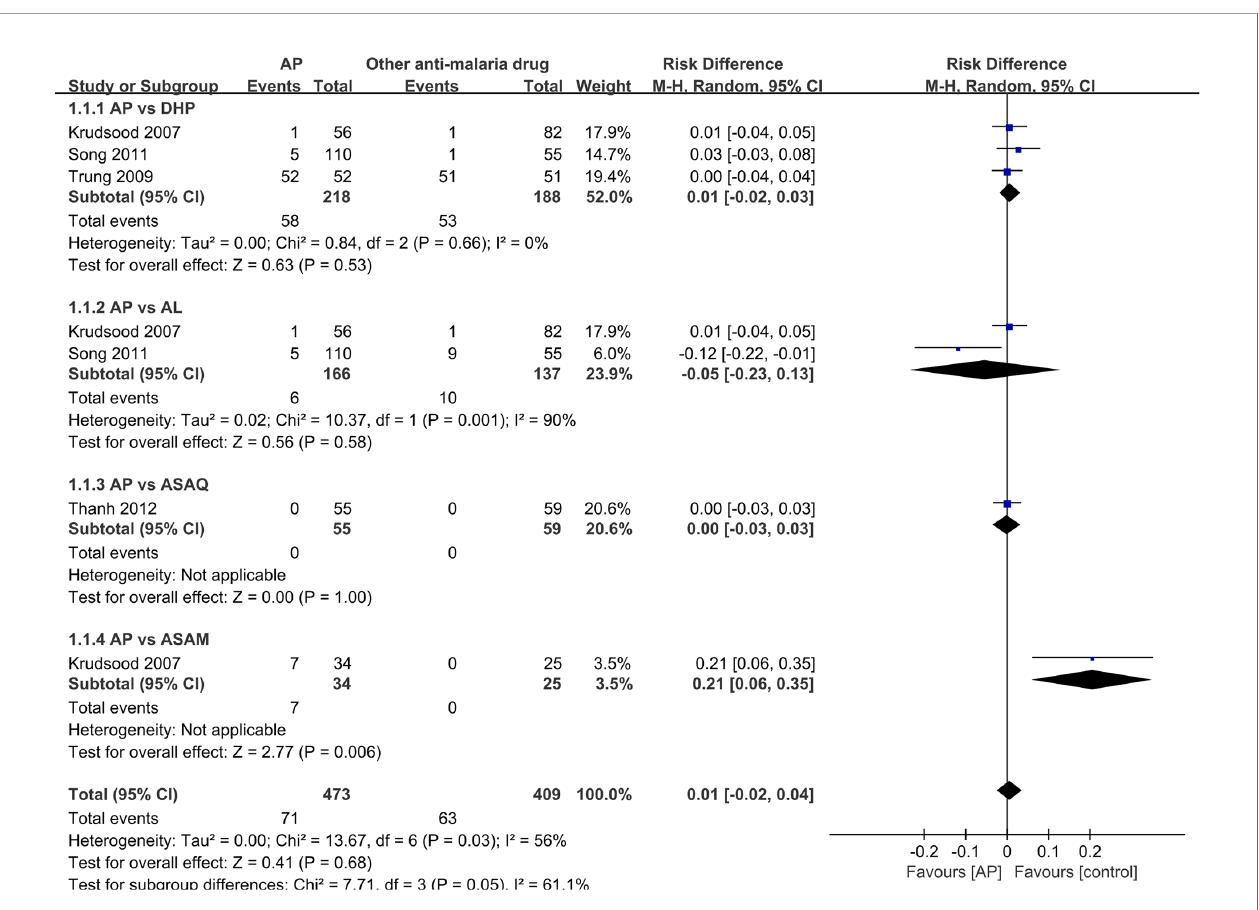
FIGURE 5 | Comparative drug recurrence rate between artemisinin – piperaquine and competing